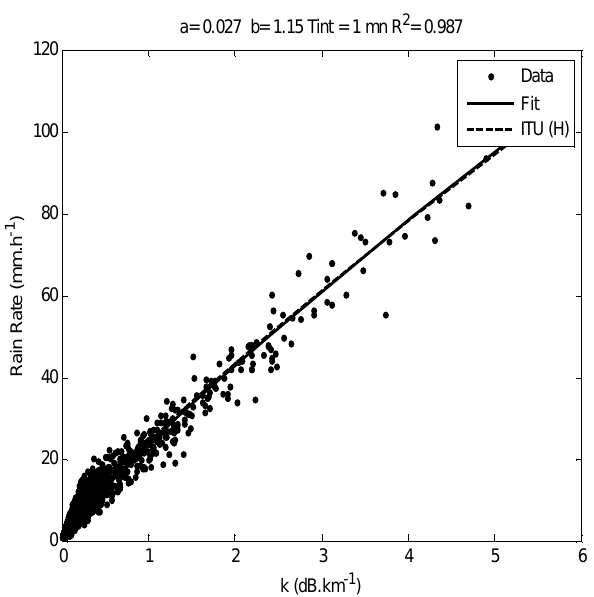
Fig. 1. Scatter plot of rain rate versus specific attenuation computed from the drop size distribution and Mie theory, for a frequency f equal to 12 GHz and a time resolution of 1 min. The continuous line indicates the corresponding fitted k-R power law. The dotted line indicates the ITU power law for the horizontal polarization.